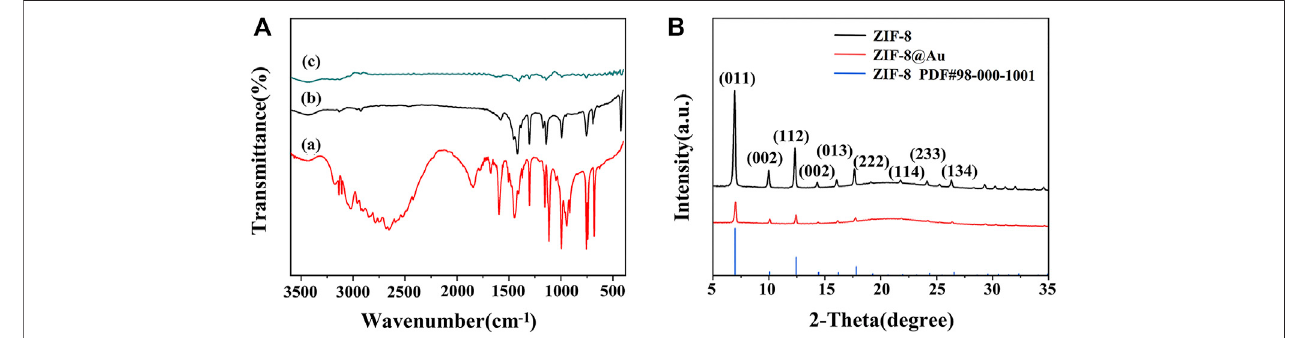
According to the IUPAC classi fi cation, two hysteresis loops of